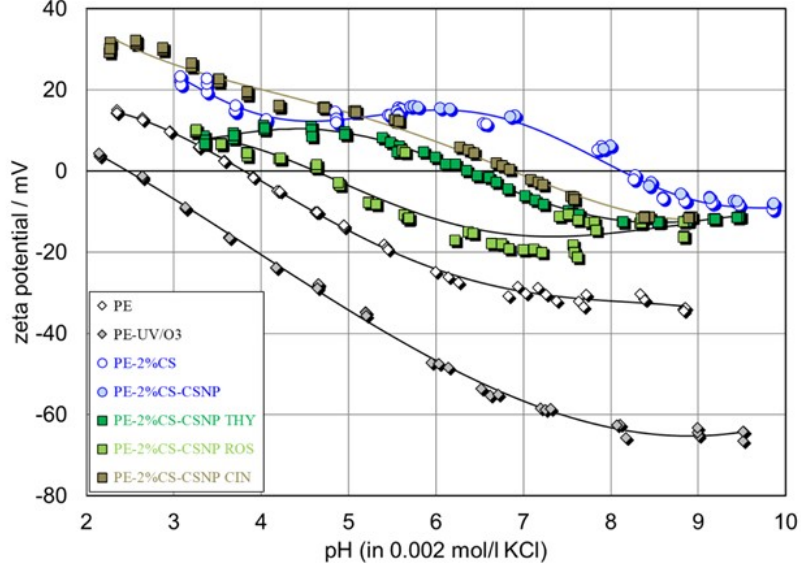
Figure 5. Zeta potential as a function of pH of PE and PE functionalized foils.